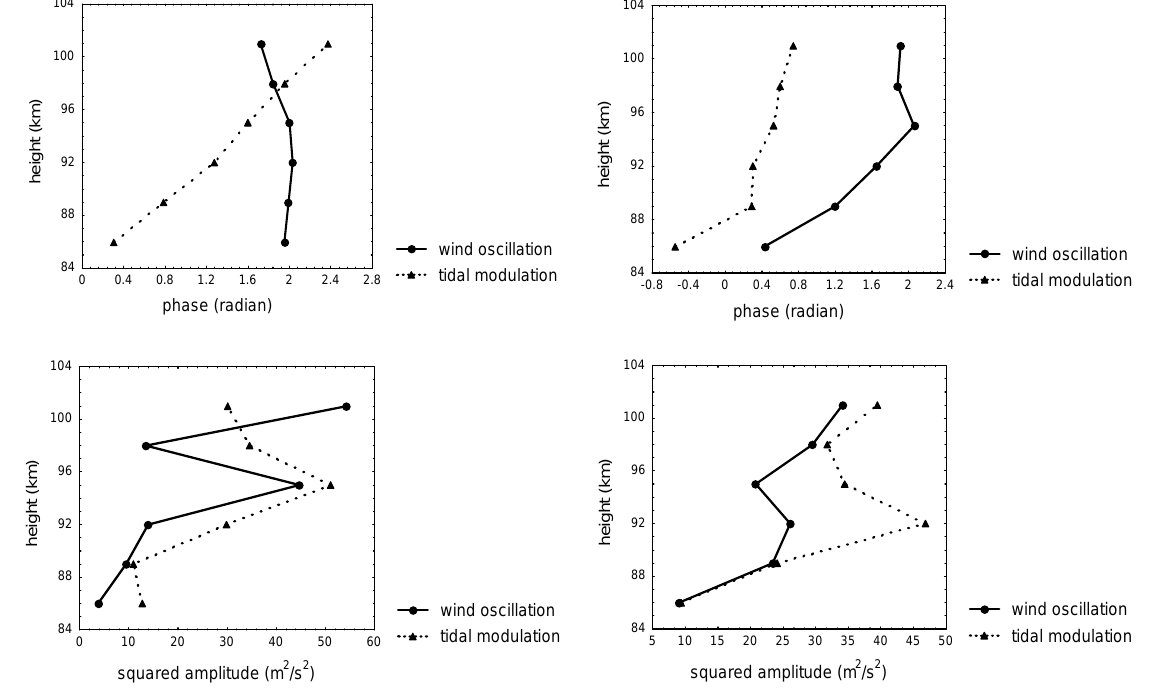
Fig. 13. Vertical profiles of the mean wind oscillation and of the modulation (a) near 14 December 1998, (b) near 9 February 1998.